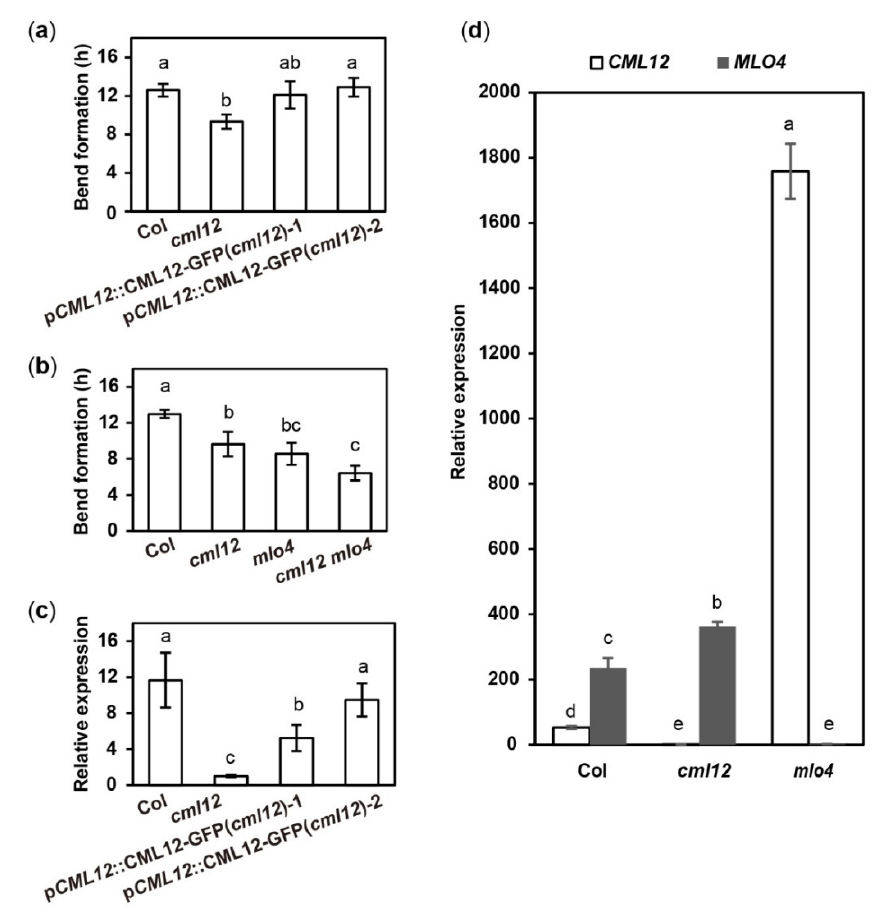
Figure 5. Quantitative analysis of bend formation and gene expression in cml12-3 and mlo4-5 mutants. cml12-3 and mlo4-5 mutants were indicated, respectively, as cml12 and mlo4 for short. ( a )The time taken to form a bend in Col, cml12-3 , p CML12 ::CML12-GFP ( cml12-3 )-1, and pCML12::CML12-GFP ( cml12-3 )-2 were 12.60 ± 0.66, 9.33 ± 0.75, 12.10 ± 1.42, and 12.90 ± 0.96 hours, respectively, 80 < n < 150. ( b ) The time taken to form a bend in Col, cml12-3 , mlo4-5, and cml12-3 mlo4-5 were 12.97 ± 0.45, 9.63 ± 1.36, 8.57 ± 1.22, and 6.43 ± 0.83 h, respectively, 80 < n < 150. ( c ) Real-time PCR showed that expression of CML12 gene was restored in p CML12 ::CML12-GFP ( cml12-3/- ) plants. (d) Real-time PCR showed that relative expression of CML12 increased significantly in mlo4-5 mutant. Different letters above the bars indicate significant differences ( P < 0.05, Bonferroni correction) in a pairwise comparison using the least significant difference (LSD) method.